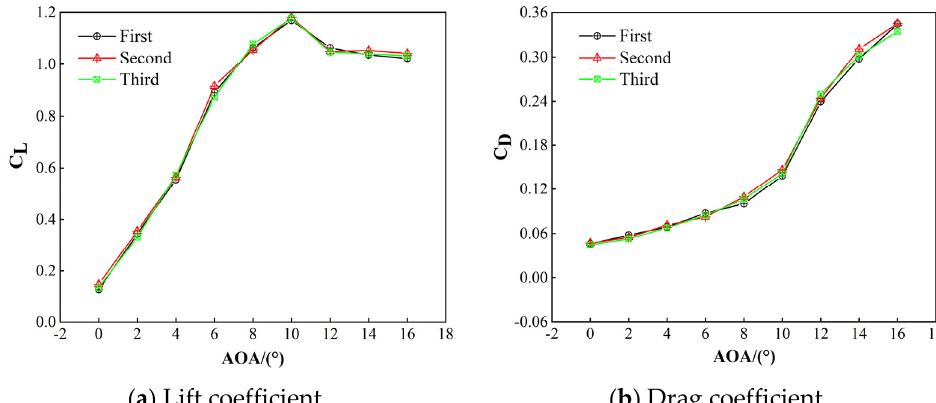
Figure 4. Verification of force repeatability of balance.